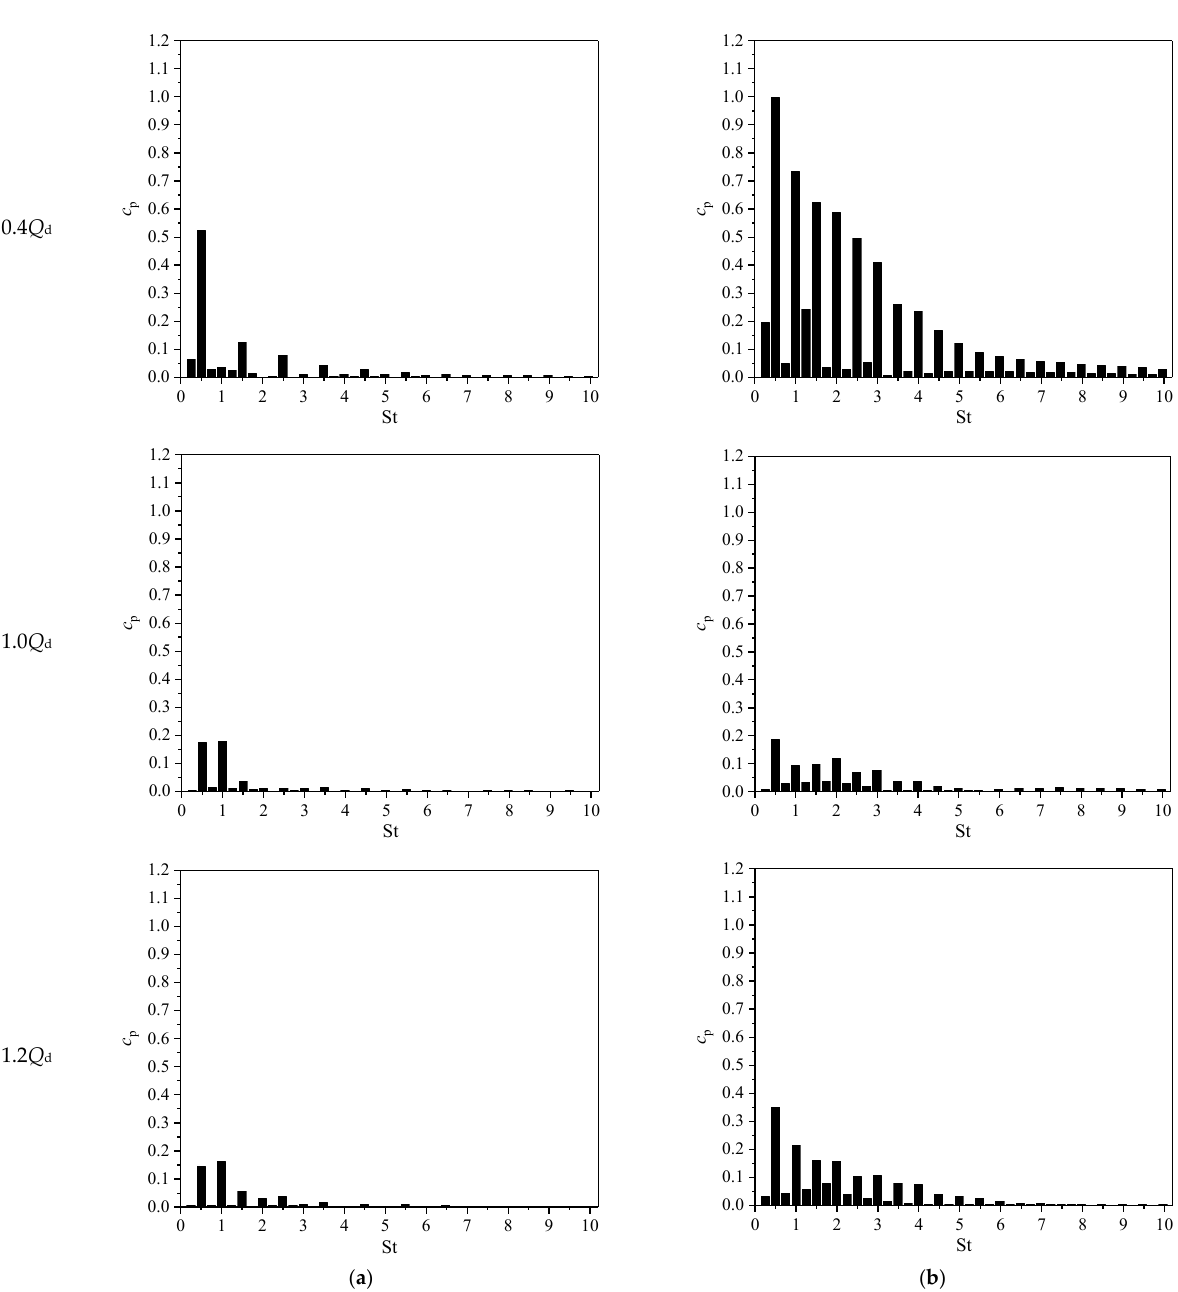
Figure 14. Frequency spectra of pressure pulsations of impeller at different flow rates: ( a ) X3; ( b ) Y3.